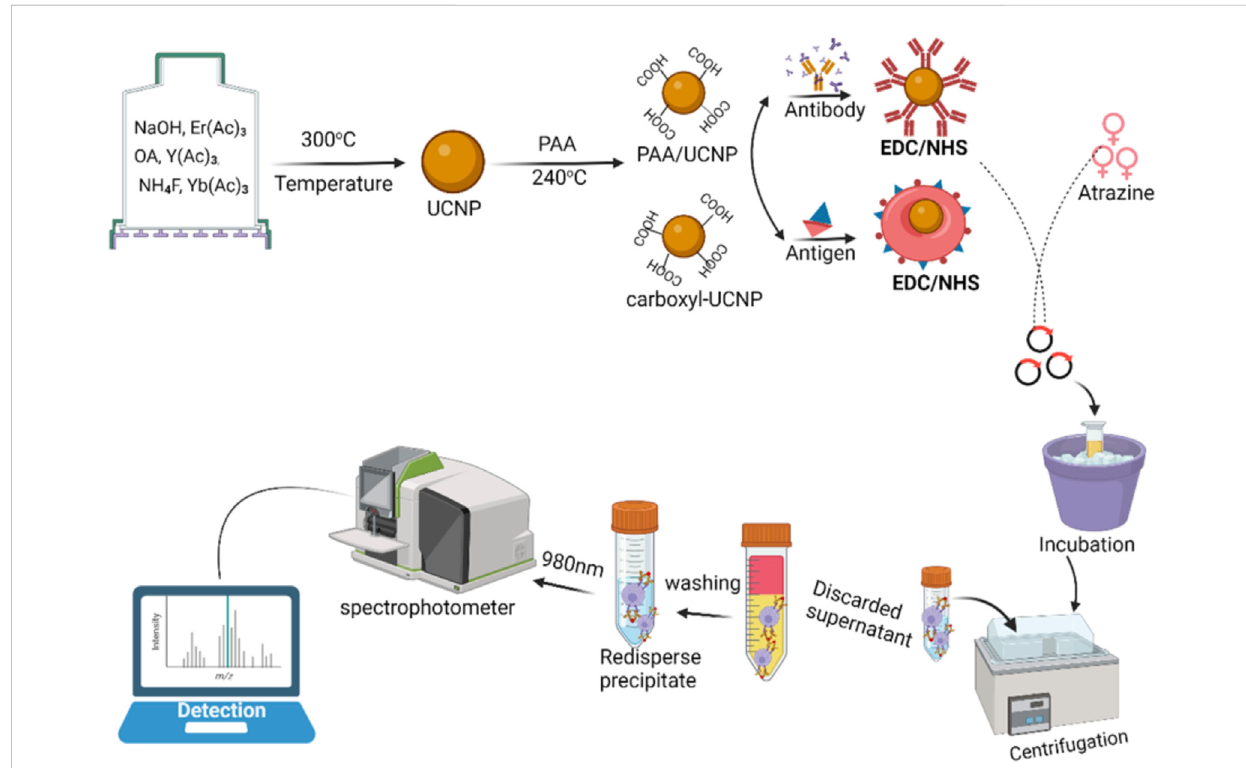
FIGURE 3 An illustration of probe fabrication and analysis based on immuno fl uorescence (competition assay for atrazine